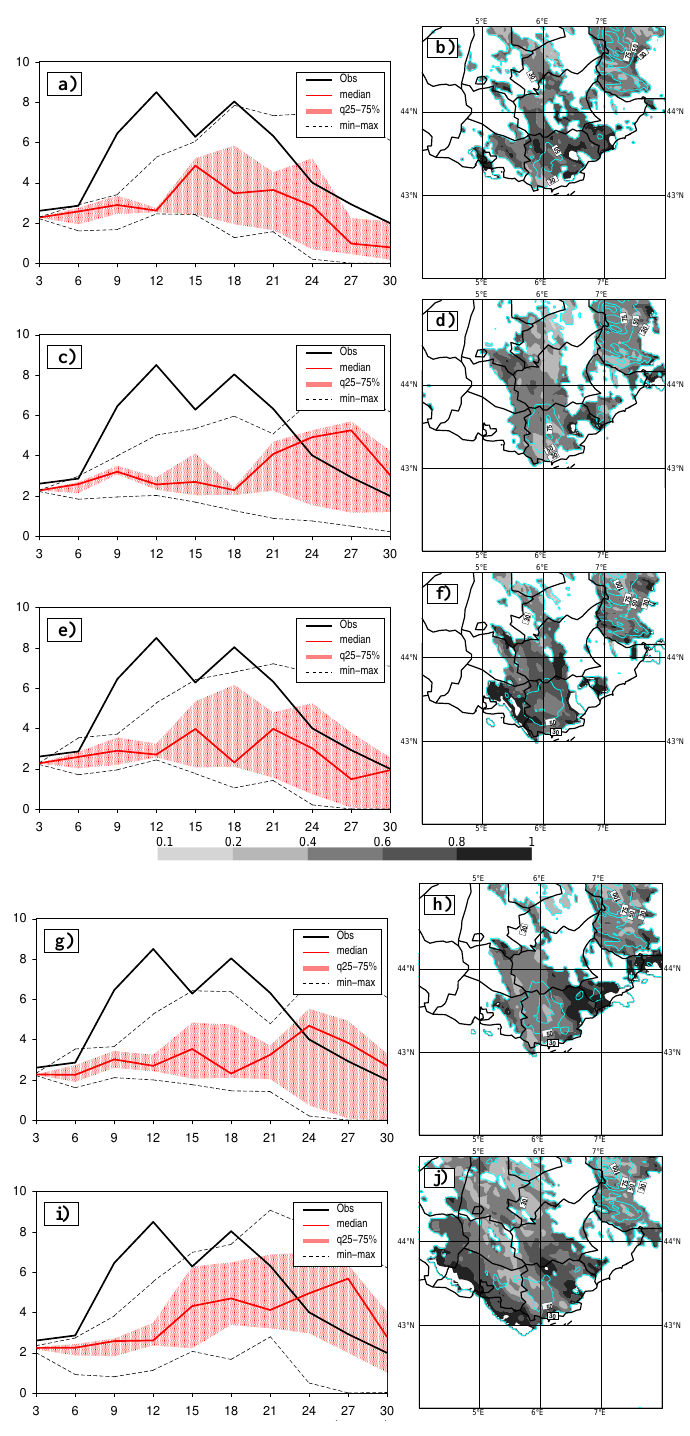
Fig. 11. Var case time series of the 3-h surface precipitation averaged over the subdomain seen in Fig. 6 and the 24-h accumulated simulated precipitation ensemble-mean (solid lines) and the normalised spread (shading) for the RAND1 ( a and b ), RAND2 ( c and d ), CLUST-REF ( e and f ), CLUST-MOIST ( g and h ), and LAG ( i and j ) ensemble experiments. Interquartile ranges (25%–75%), minimum, maximum and medians are shown. The accumulation 24-h period starts on 15 June 2010 at 00:00UTC and ends on 16 June 2010 at